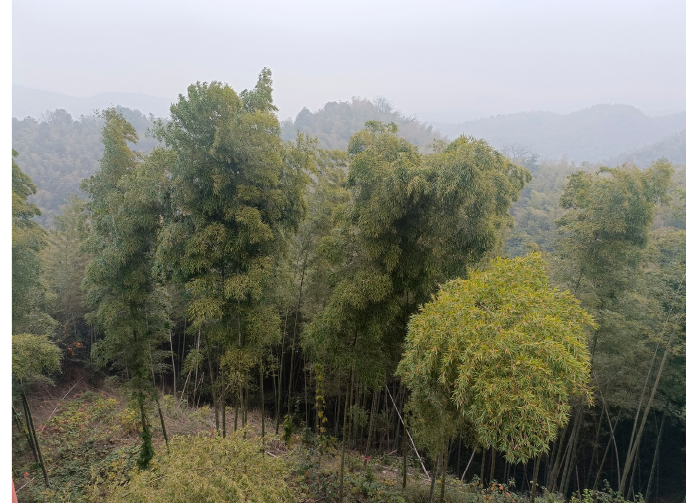
Figure 1. Jinpen Mountain bamboo forest. Table 1. Similarity ratio of physical quantities in model tests.